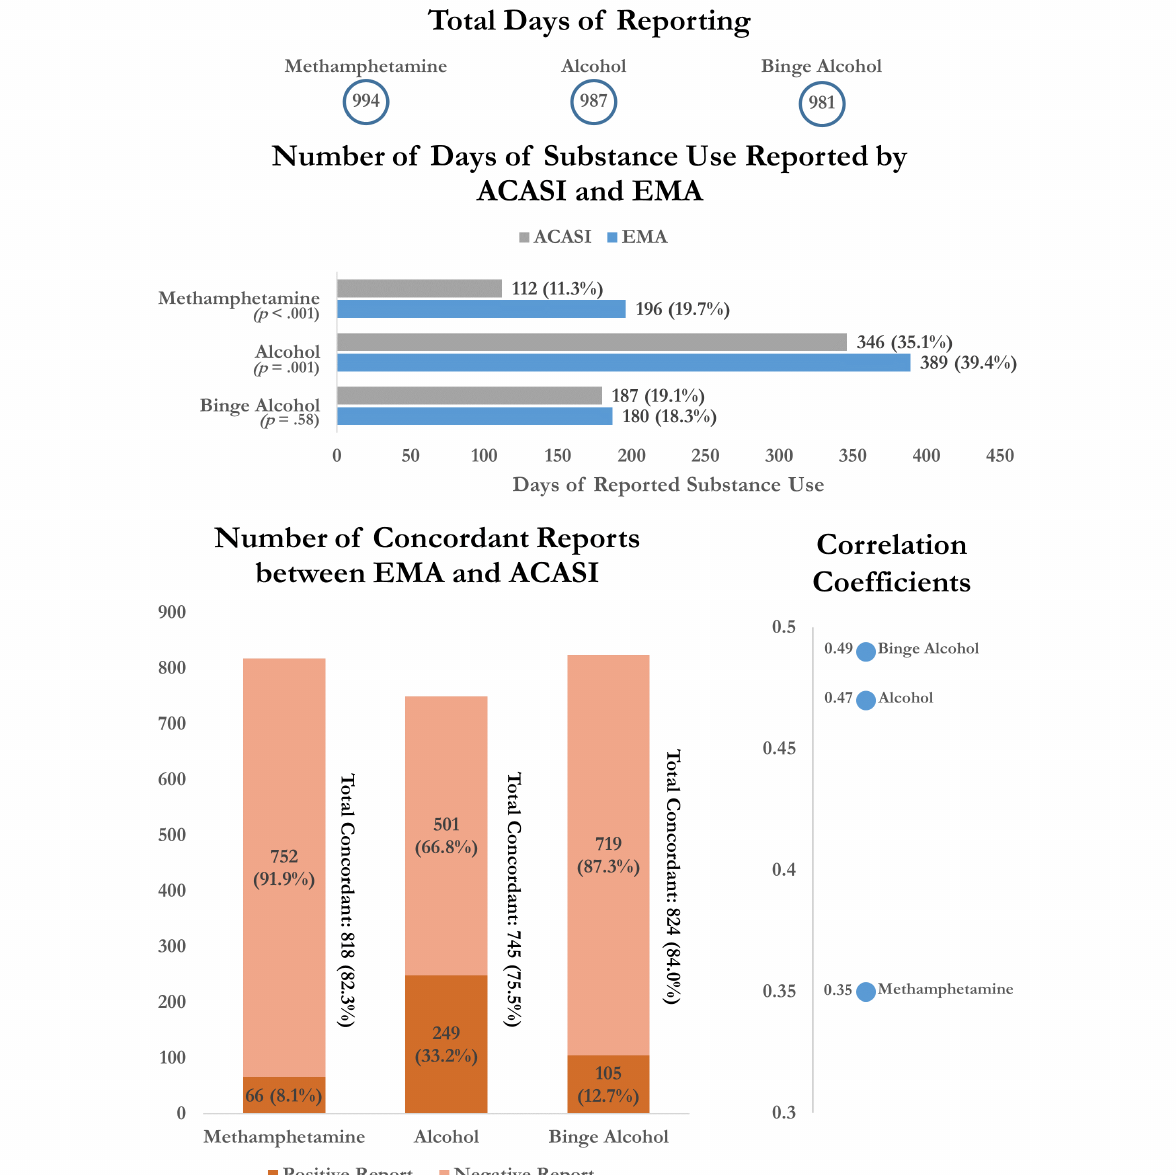
Figure 1. Reporting and concordance measures for entire pooled sample (n =